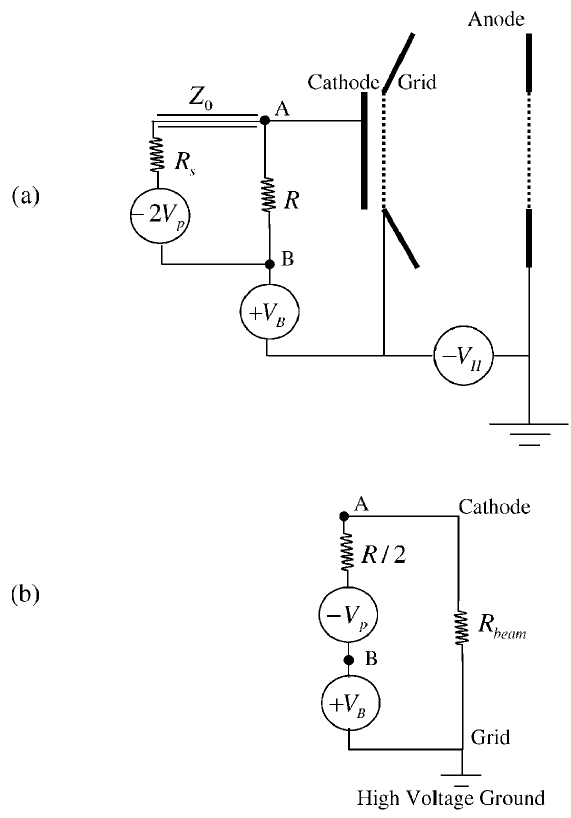
FIG. 12. (a) Basic electronic circuit of the triode electron gun. (b) Simplified equivalent circuit between the cathode and the grid of the gun.